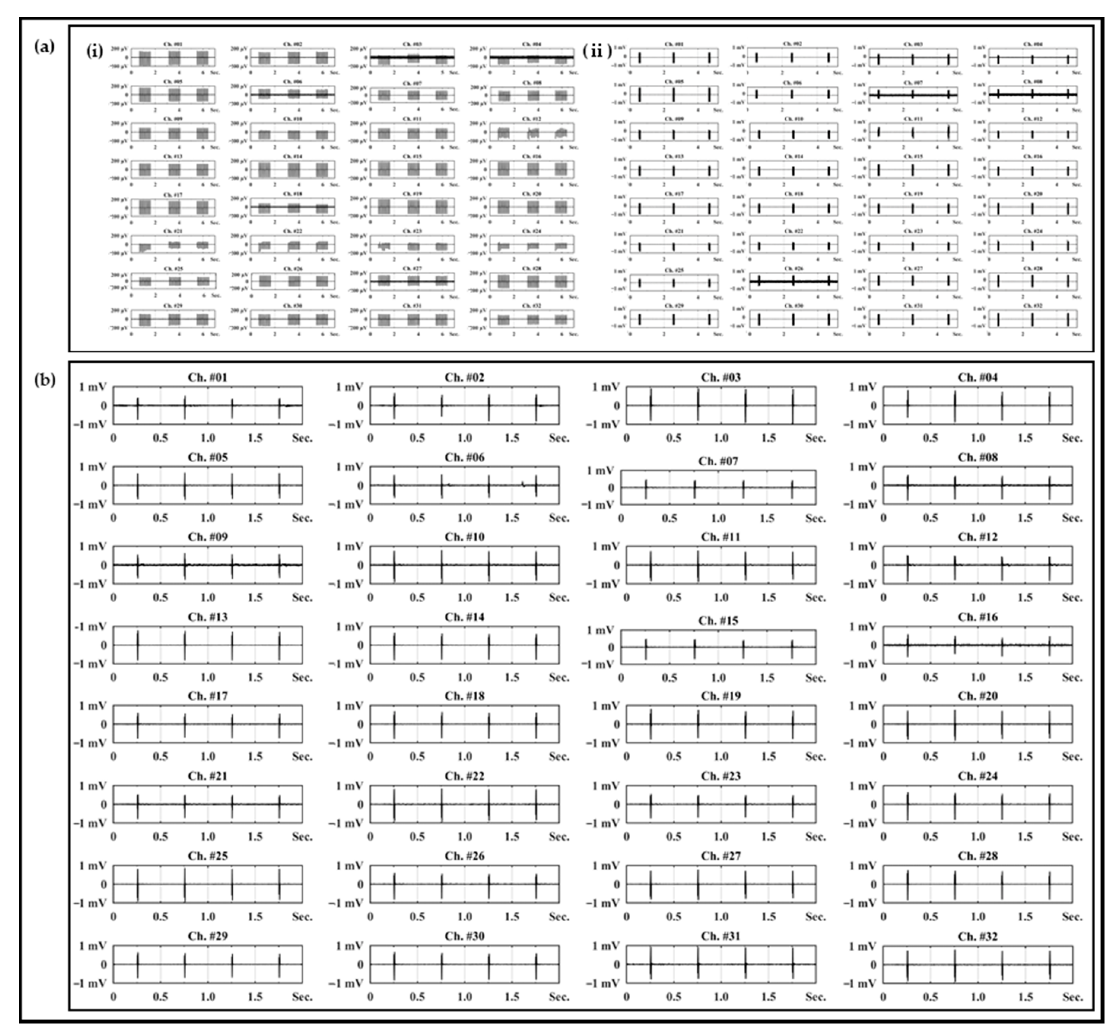
Figure 5. Results of in vitro and acute in vivo experiments. ( a ) Recording results in PBS in vitro experiment with different biphasic stimulation parameters (50 μ A-100 μ s-10 Hz and 200 μ A-100 μ s-100 Hz) and ( b ) in vivo recording results in sciatic nerve of New Zealand white rabbit with biphasic stimulation parameter (200 μ A-100 μ s-1 Hz) . Table 1. Comparison of the characteristics of signals acquired through in vitro and in vivo experiments.